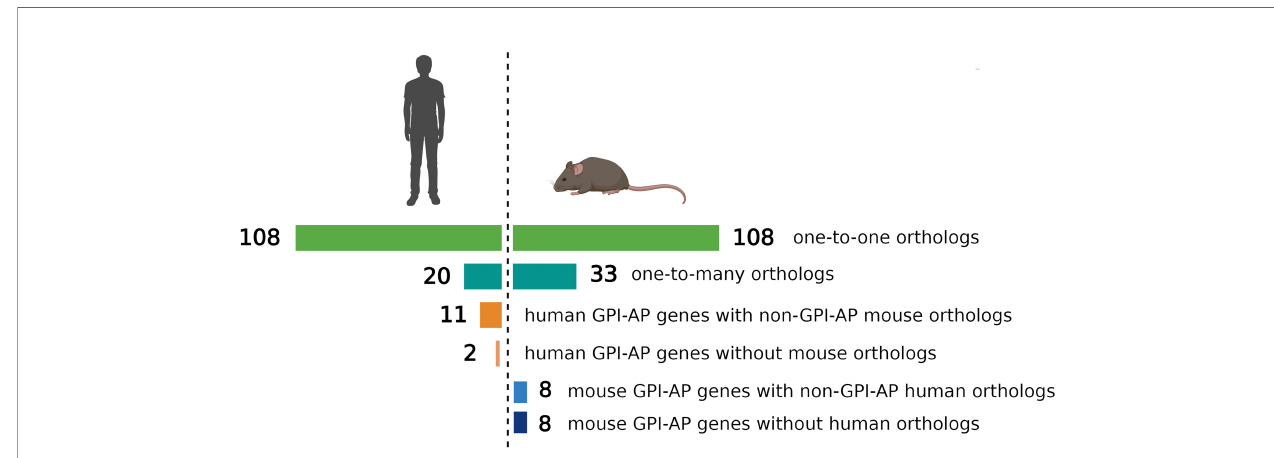
FIGURE 4 | Comparison of evolutionary conservation of GPI-anchored proteins between humans and mice. 108 human GPI-AP genes had one-to-one orthologs in mouse, 20 human GPI-AP genes had more than one mouse ortholog (n=33), 11 human GPI-AP genes were orthologous to mouse genes whose products were not